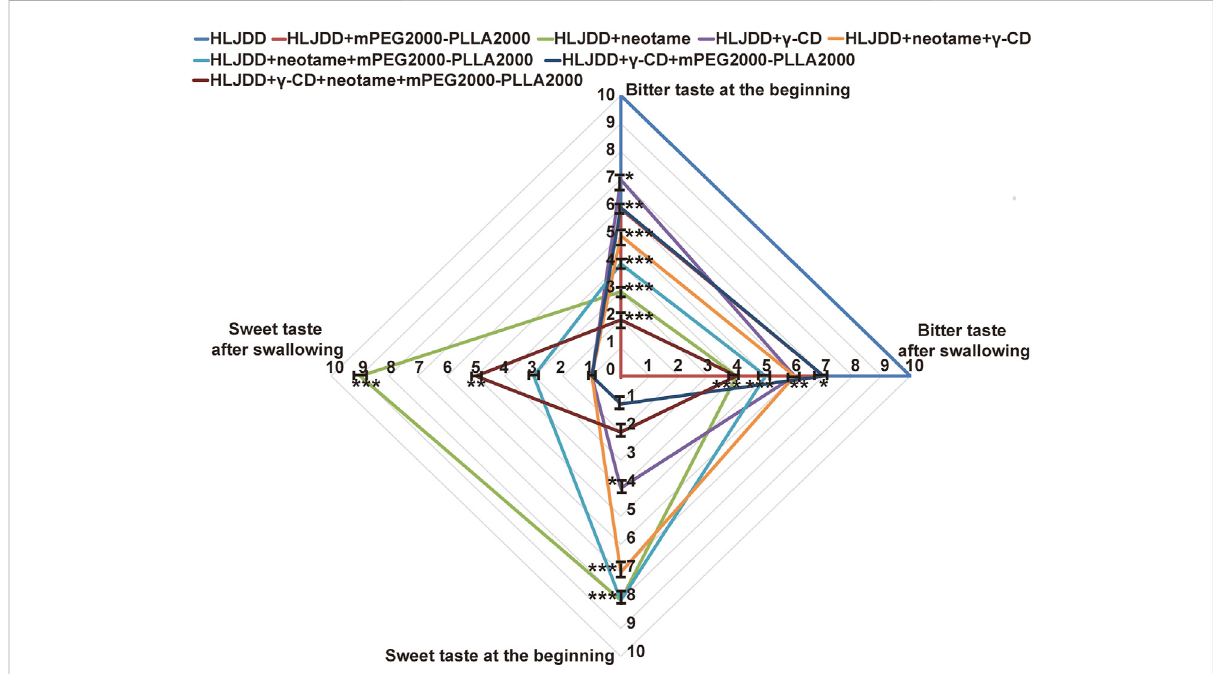
FIGURE 4 Taste-maskingeffectoftastemaskformula( n =15, ‾ x±SD).Datashownarethemean±SD.* p < 0.05,** p < 0.01,and*** p <